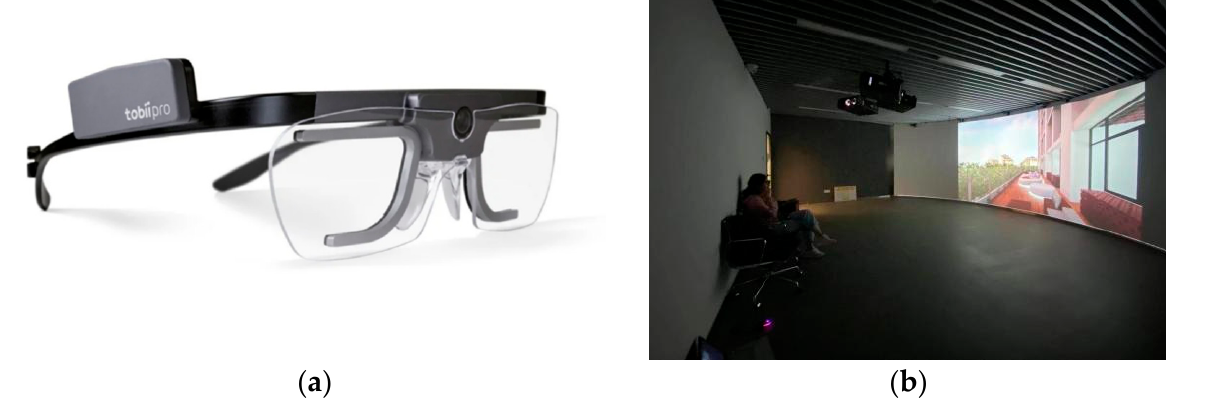
Figure 5. Visual perception experiment. ( a ) Wearable eye-tracker Tobii Glasses 2. ( b ) Experiment in the digital laboratory. the digital